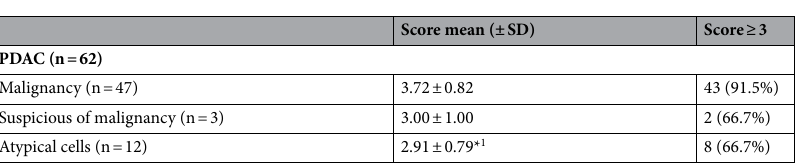
Table 6. Tissue amount assessed using scoring system according to histological results of PDAC. 1 P = 0.005, Malignancy vs atypical cells.